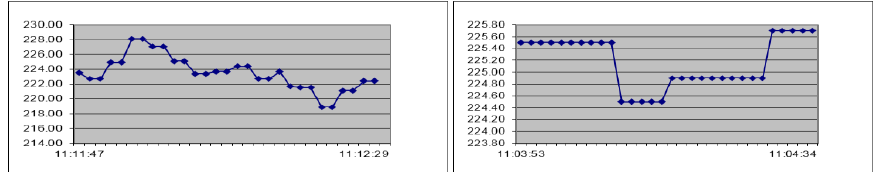
Fig. 9. Experimental results DMC